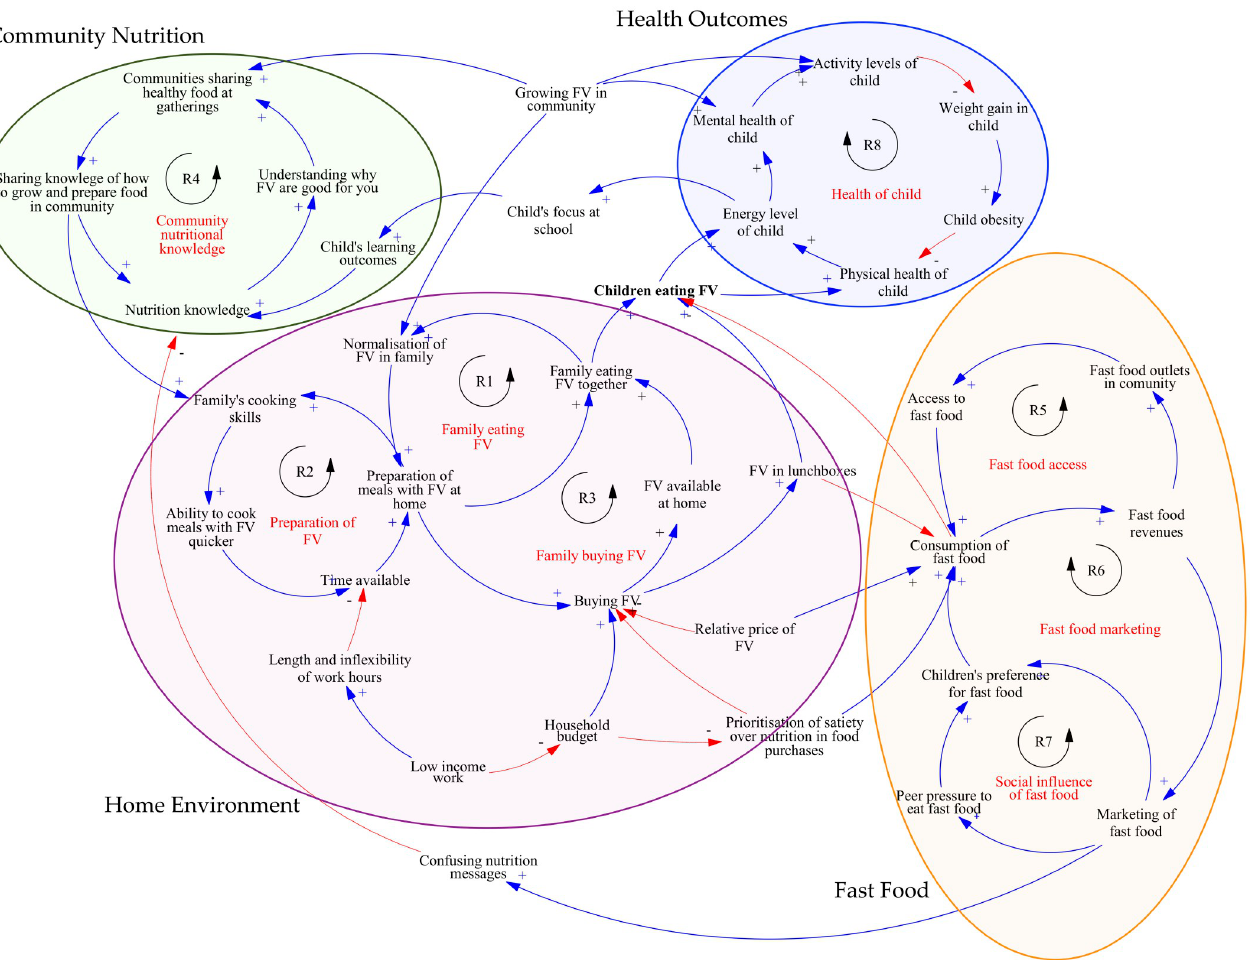
Fig 1. Community food system map (causal loop diagram). A causal loop diagram (CLD) uses arrows to indicate a causal relationship between variables in a system [25]. The CLDs created in this study describe the causal connection between variables that workshop participants deemed to be important, highlighting the feedback processes that determine system behaviour [25]. A blue arrow with a plus symbol shows that the two variables move in the same direction; if the variable at the tail of the arrow increases or decreases, the variable at the head also increases or decreases, respectively. A red arrow with a minus symbol indicates that the two variables move in opposite directions: if the variable at the arrow tail increases, the variable at the head decreases (and vice versa). The causal loops within the CLD illustrate the way in which a chain effect of a cause can be traced through a set of related variables, back to the original cause [25]. All causal loops in this systems map are reinforcing, indicated with an R in the diagram, which means that they perpetuate either a vicious or virtuous cycle [25].